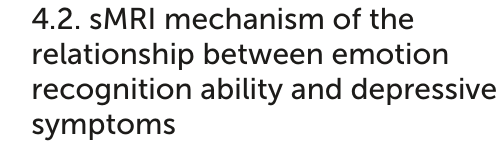
TABLE 2 Correlation analysis and mediating analysis of common brain structure between emotion recognition ability and depressive symptoms. A/B The average accuracy ASR score of depression syndrome